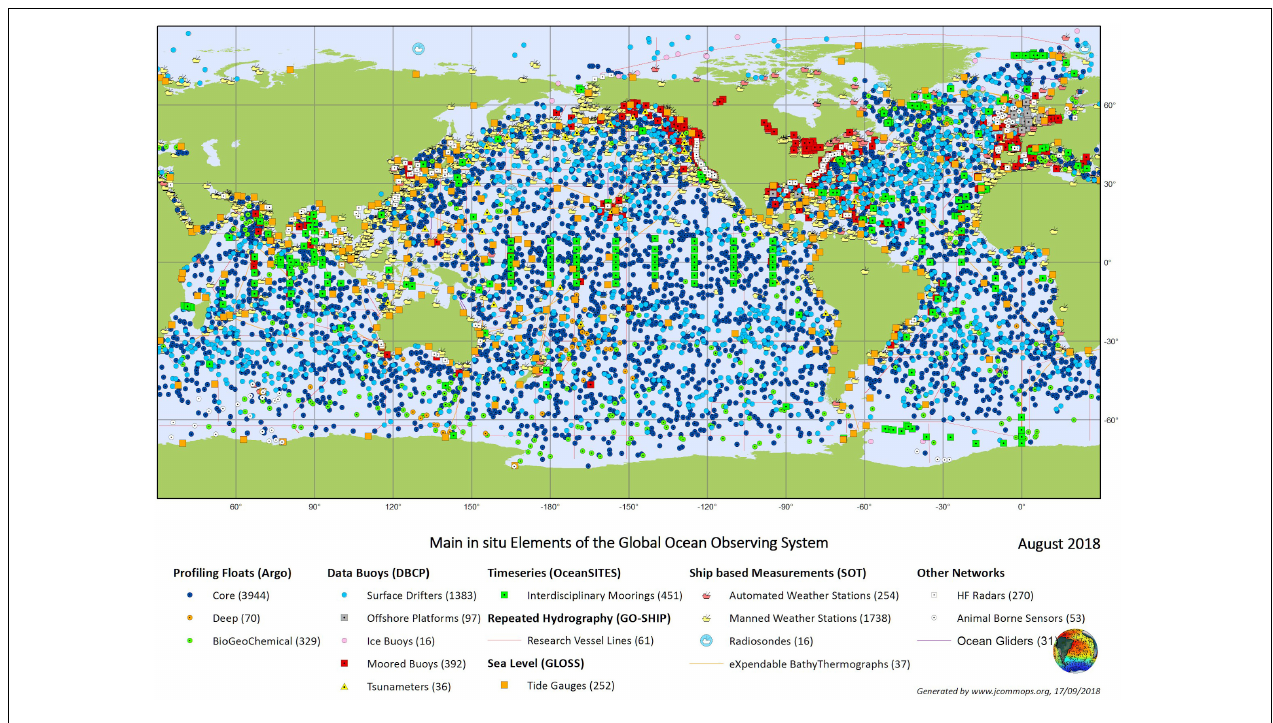
FIGURE 4 | A snapshot of global ocean observations generated by JCOMMOPS (JCOMM,